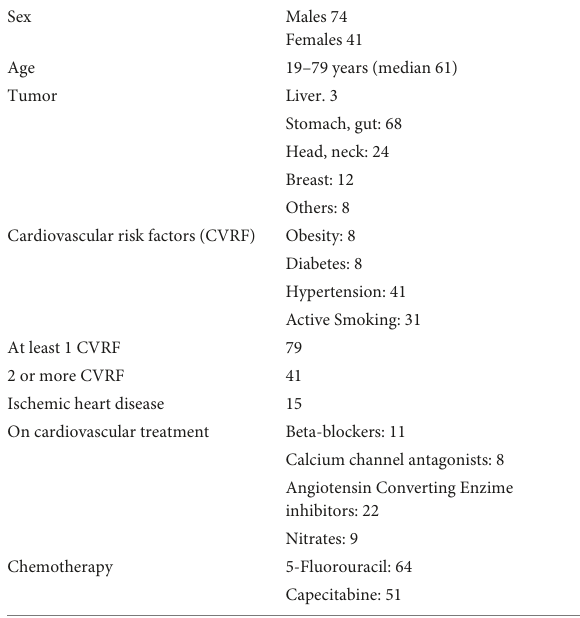
TABLE 2 Characteristics of the